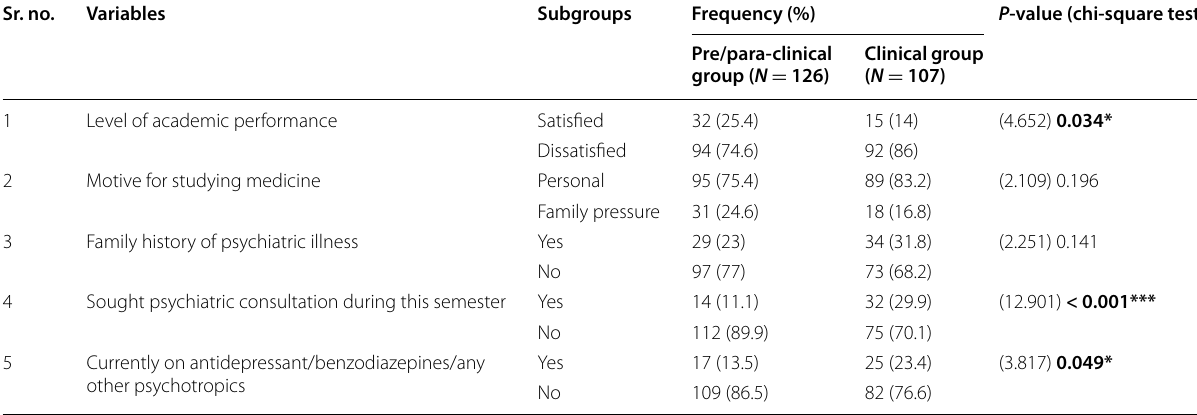
Table 6 Comparison of association of academic and personal characteristics between pre/para-clinical and clinical students with psychological morbidities